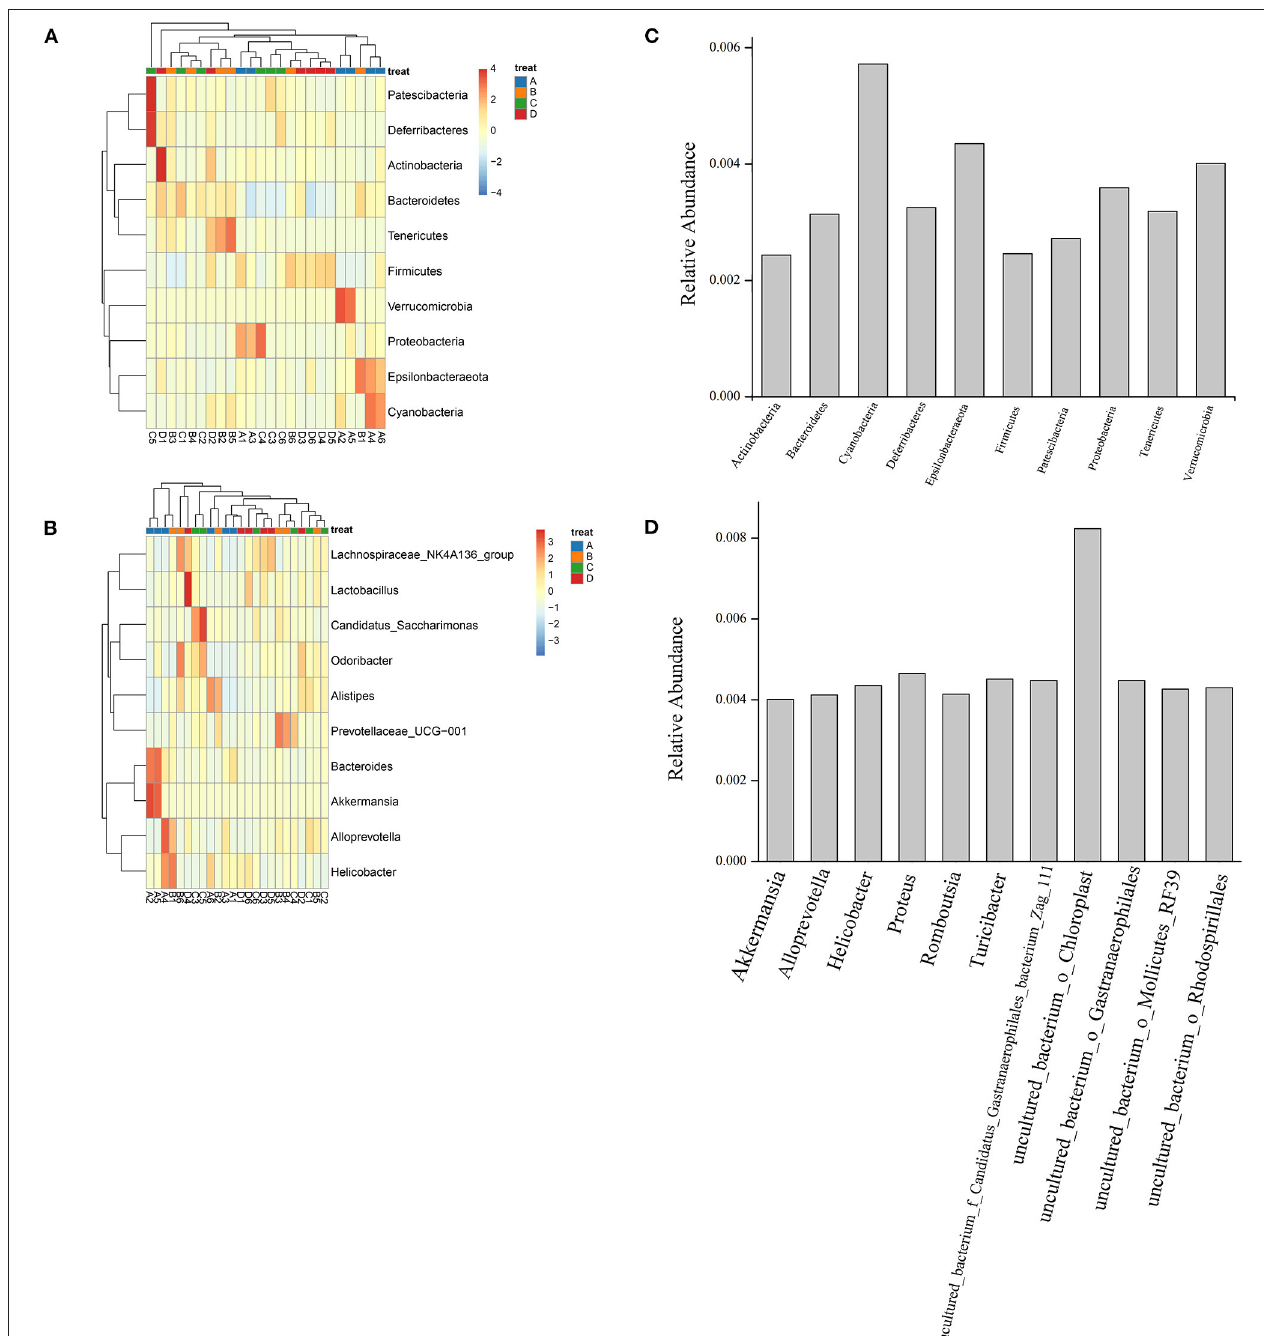
FIGURE 1 | Species distribution heatmap at phylum (A) and genus level (B) and relative abundance of aging related bacteria at phylum (C) and genus level (D) of gut microbiota of mouse fecal in four groups. A1-A6: NT-free group; B1-B6: basal diet group; C1-C6: NT intervention group; D1-D6: model control group.